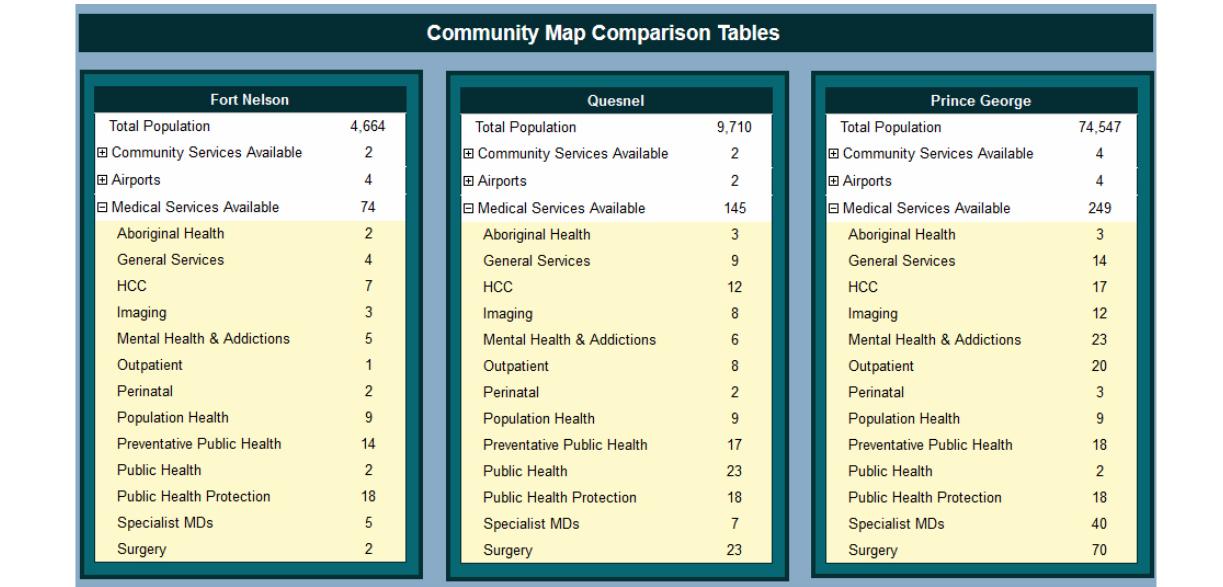
Figure 9. Community comparison tables.